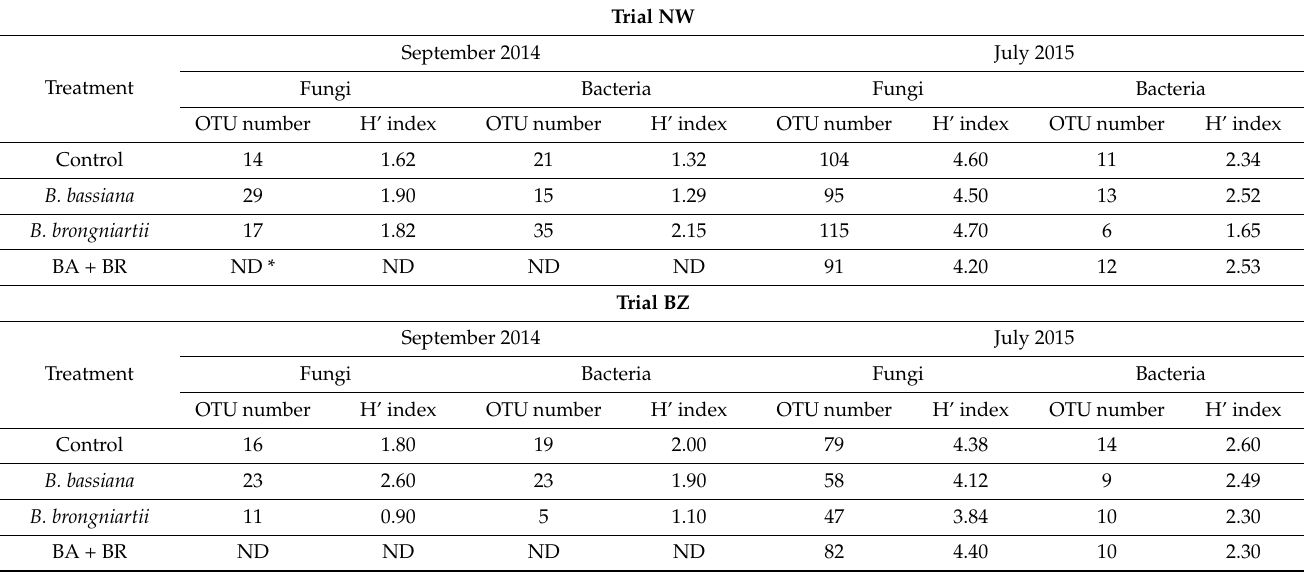
Table 3. Effect of application of the bioinoculum of the two strains of the entomopathogenic fungal species ( B. bassiana and B. brongniartii ) alone or co-inoculated (BA + BR) on OTU numbers and Shannon–Wiener diversity index calculated from TRFLS data of soil samples from the two